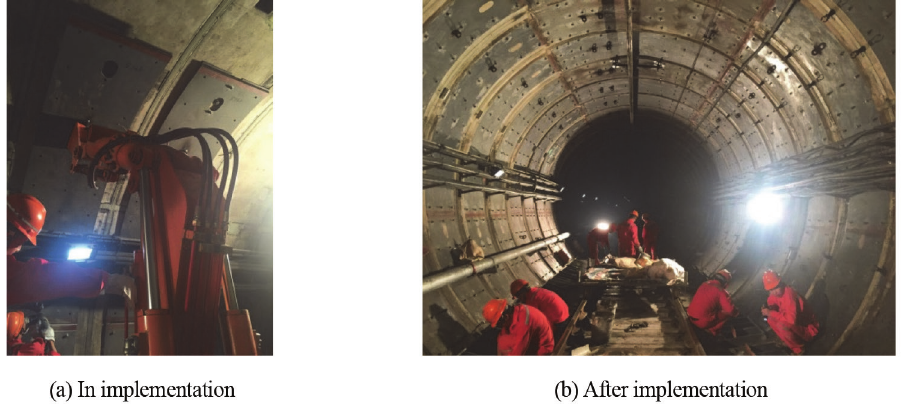
Figure 5. Implementing steel plate bond reinforcement for metro tunnels